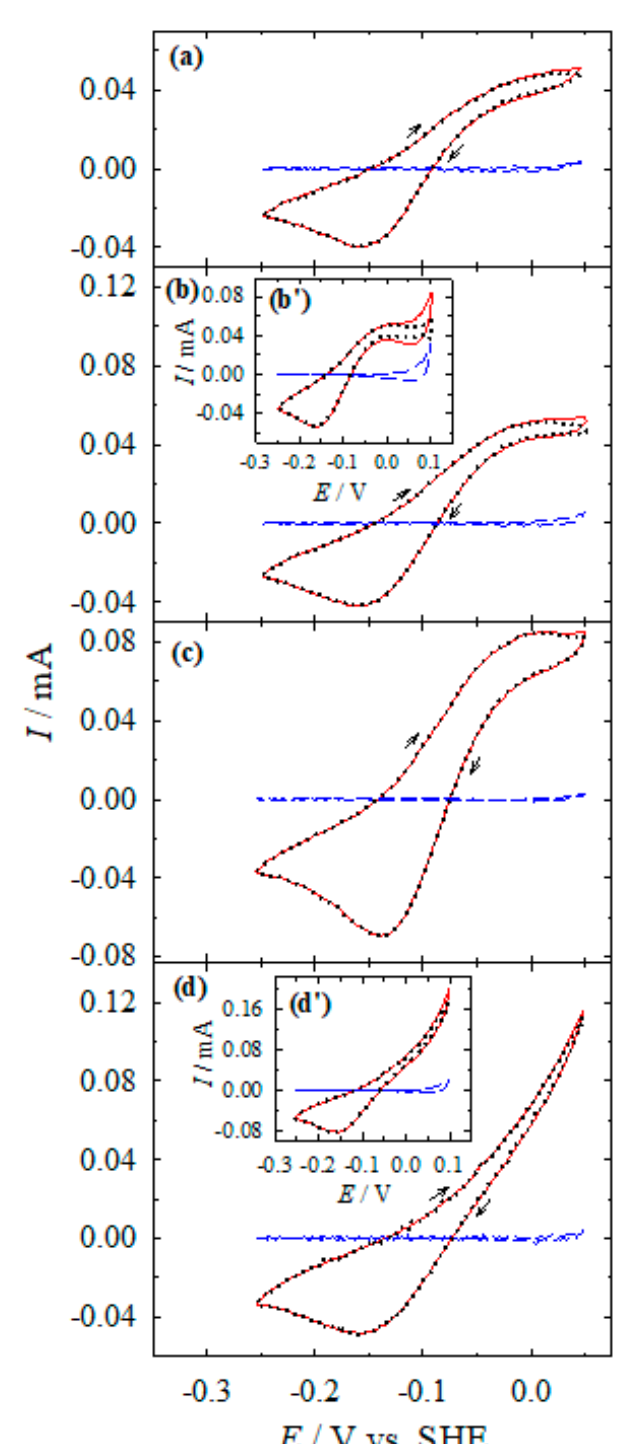
Figure 9. Dependencies of the current (measured directly (solid line), calculated from EQCM data (dashed line), and their difference (dotted line)) on silver electrode potential. Solution composition (M): CoSO 4 —0.1; NH 3 —4.0; KCl: 0 ( a ), 10 − 3 ( b ), 10 − 2 ( c ), and 10 − 1 ( d ); pH 10.9; 20 °C. Potential scan rate 2 mV s − 1 . The insets ( b ’) and ( d’ ) represent the cyclic voltammograms (CVs) at the anodic potential limit of 0.1 V.